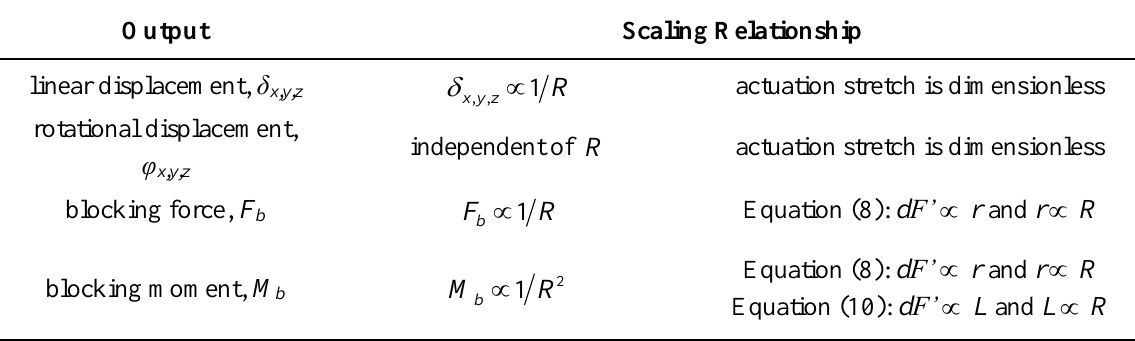
Table 1. Scaling of cube DEA output assuming r/R and L/R are